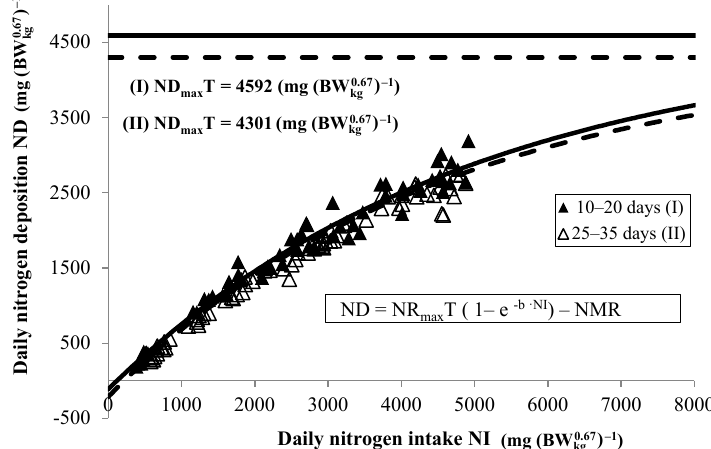
Figure 1. Results of N rise experiments with growing chickens (Ross 308) depending on age period for estimating the threshold value ND max T (Pastor et al.,